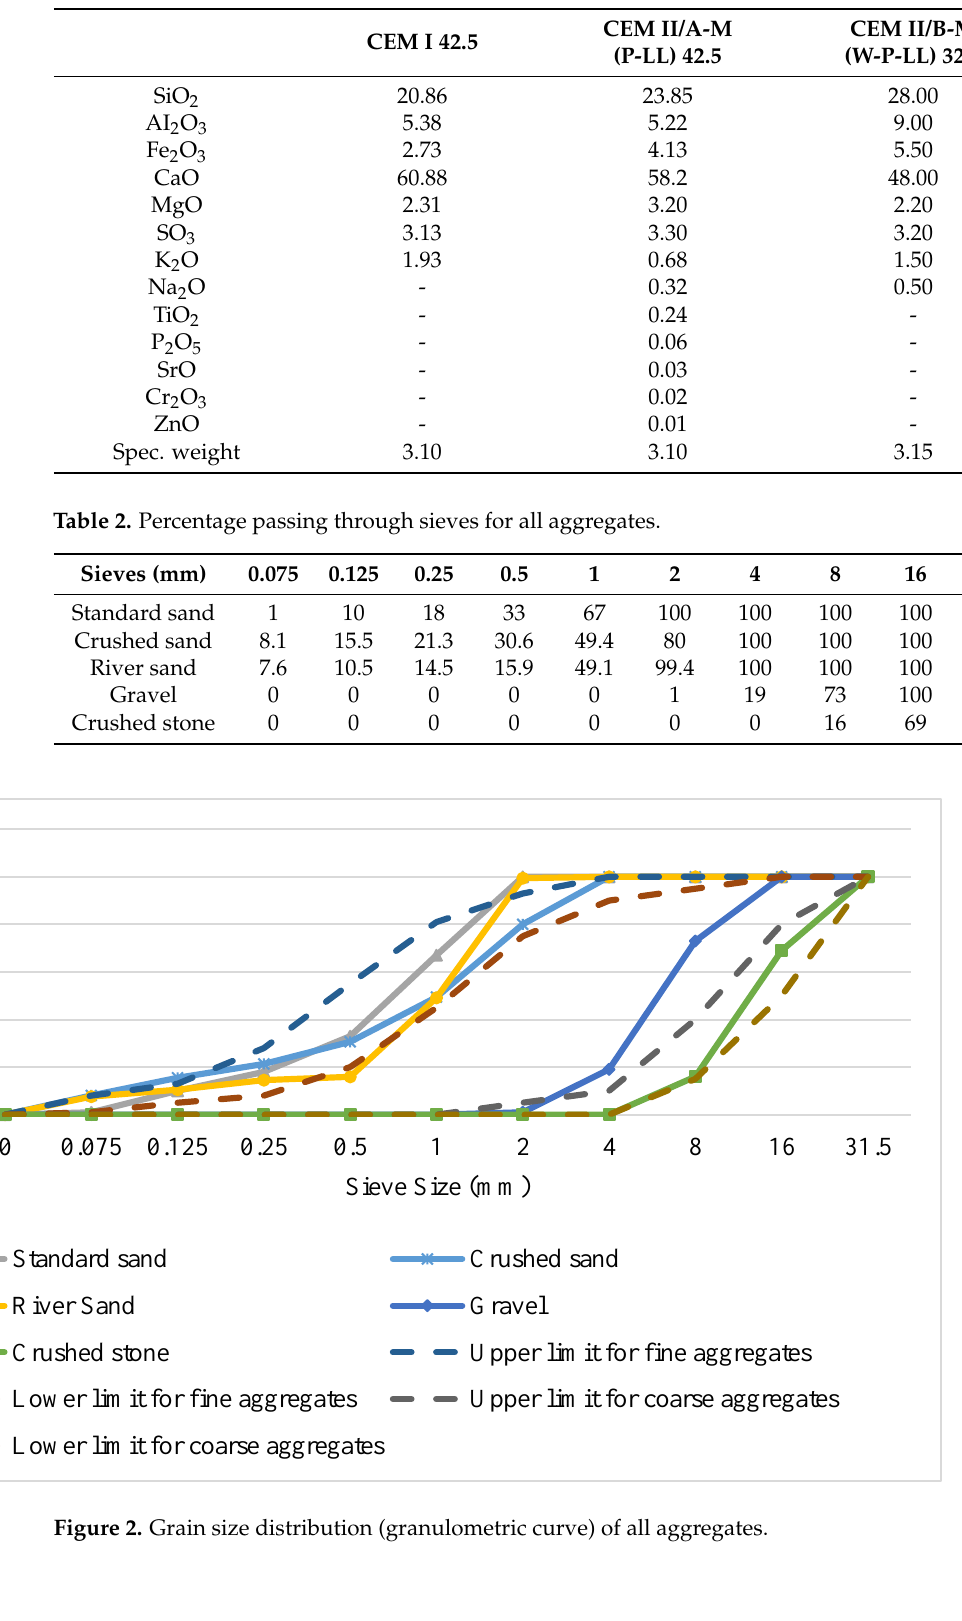
Table 1. Chemical analysis and specific weight of cements.